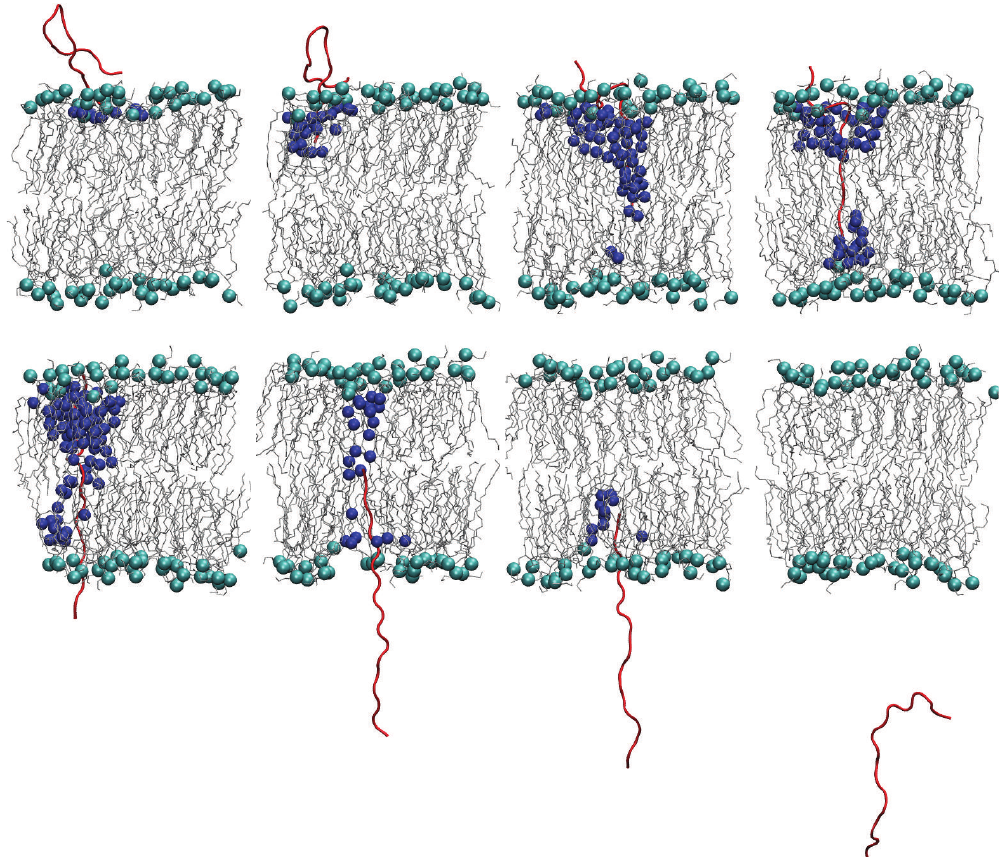
Figure 1: Snapshots for the SMD simulation on pVEC peptide as it moves across the bilayer. The peptide backbone is shown in red in cartoon representation, the phosphate heads are shown as cyan spheres, the lipid tails are shown in gray, and the water molecules are shown as blue spheres. Hydrogens in the lipids and water molecules are omitted for clarity.